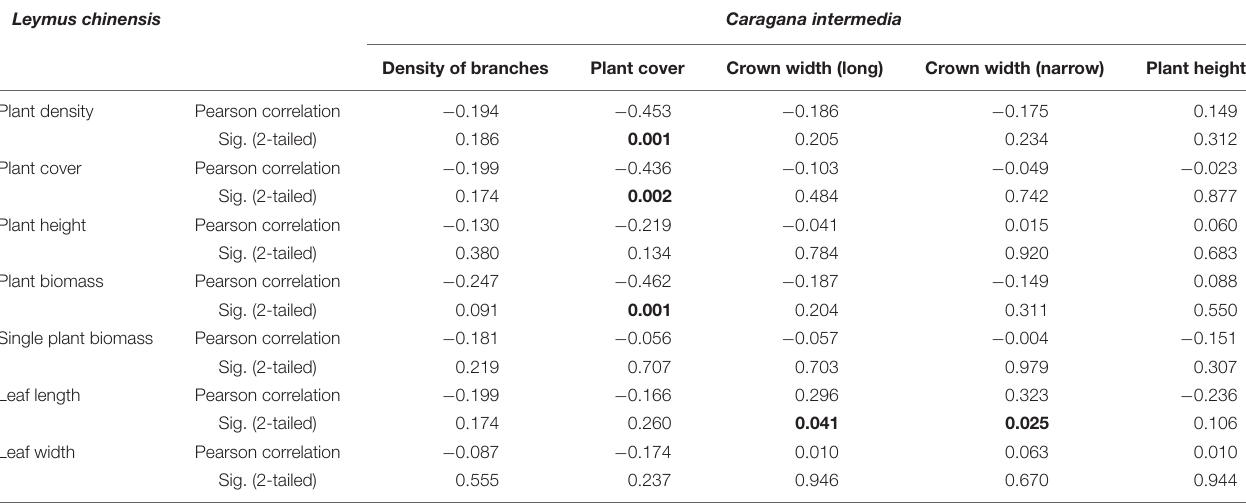
TABLE 2 | The relationships between characteristics of the shrub species Caragana intermedia and the clonal herbaceous plant Leymus chinensis . Leymus